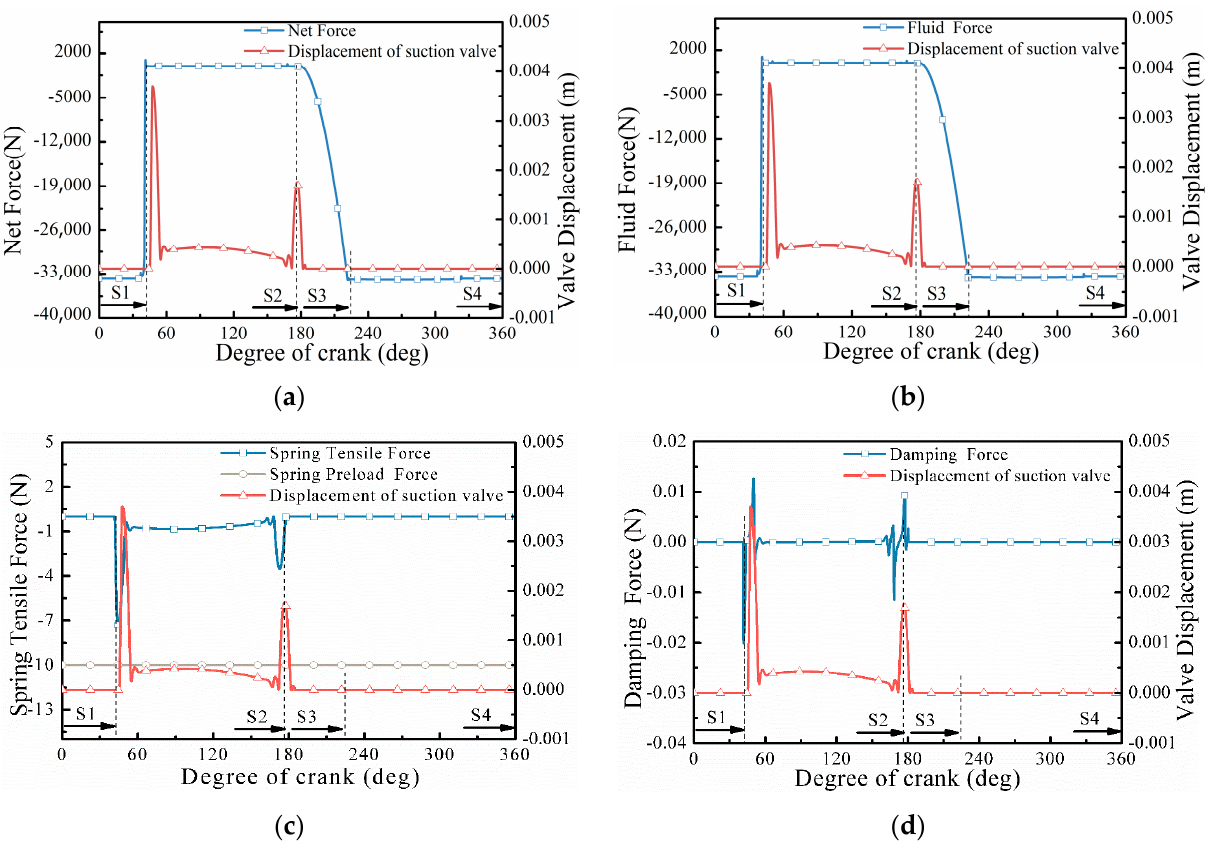
Figure 10. Coupling of force and the displacement curve of the suction valve. S1, expansion stroke; S2, suction stroke; S3, compression stroke; S4, discharge stroke. ( a ) Coupling of suction valve net force, displacement, and crank angle. ( b ) Coupling of suction valve hydrodynamic force, displacement, and crank angle. ( c ) Coupling of spring force and displacement of the suction valve with the crank angle. ( d ) Coupling of suction valve damping force, displacement, and crank rotation angle.